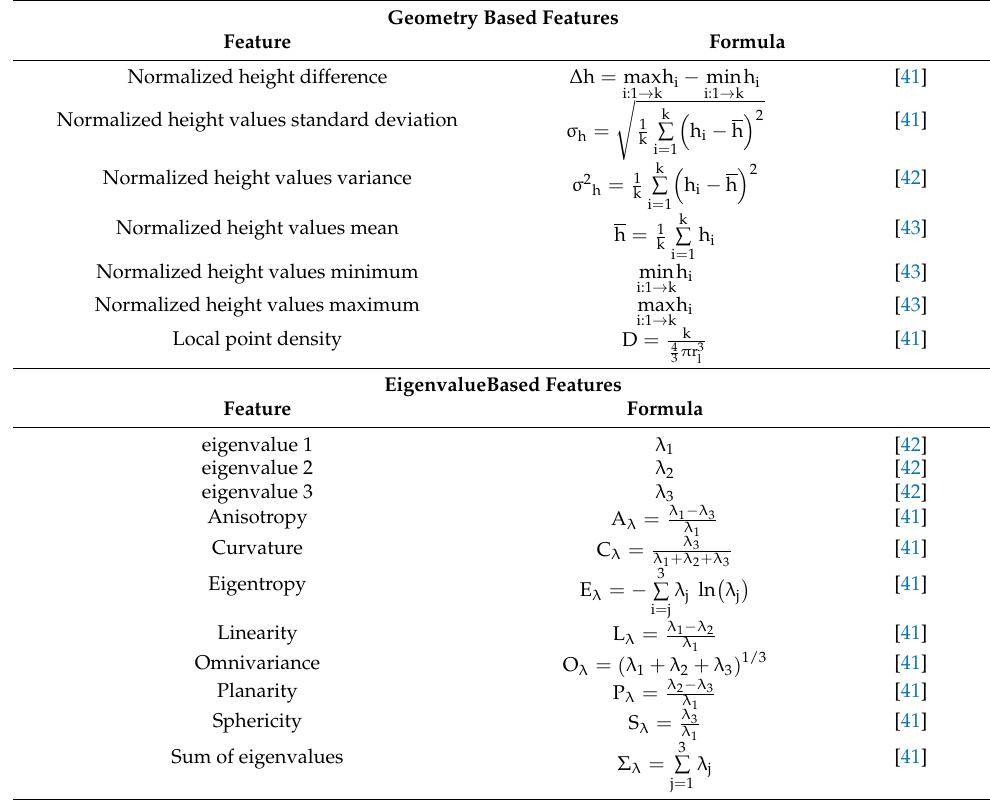
Table 2. Geometry and eigenvalue based features calculated for classification of LiDAR point cloud data into vLE